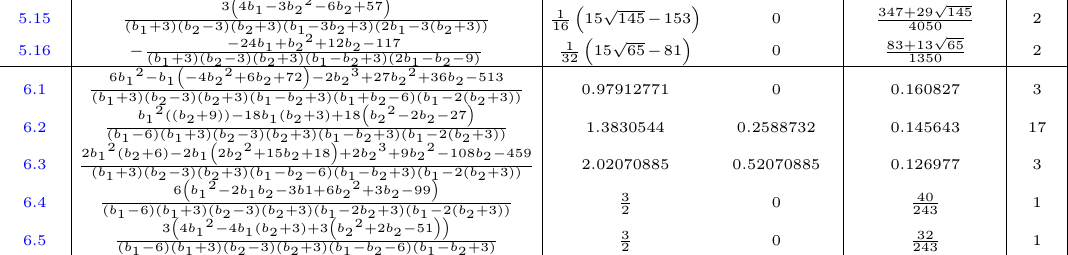
and their corresponding volume minima i